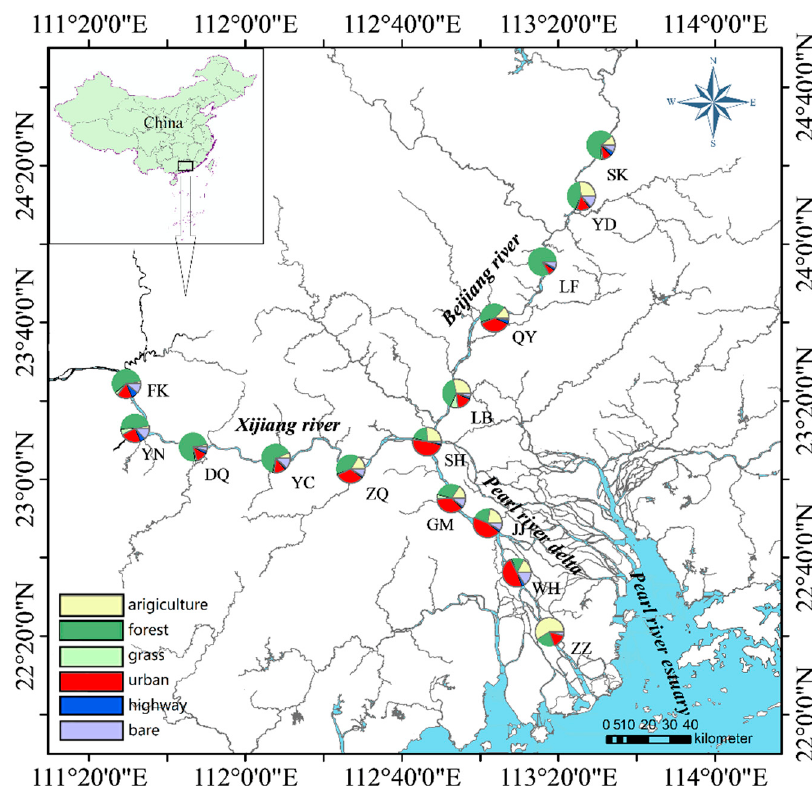
Figure 1. Location of the Pearl River study sites. Pie plot shows land use cover (%).